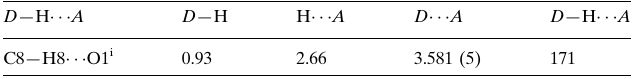
Hydrogen-bond geometry (A˚ , (cid:2)